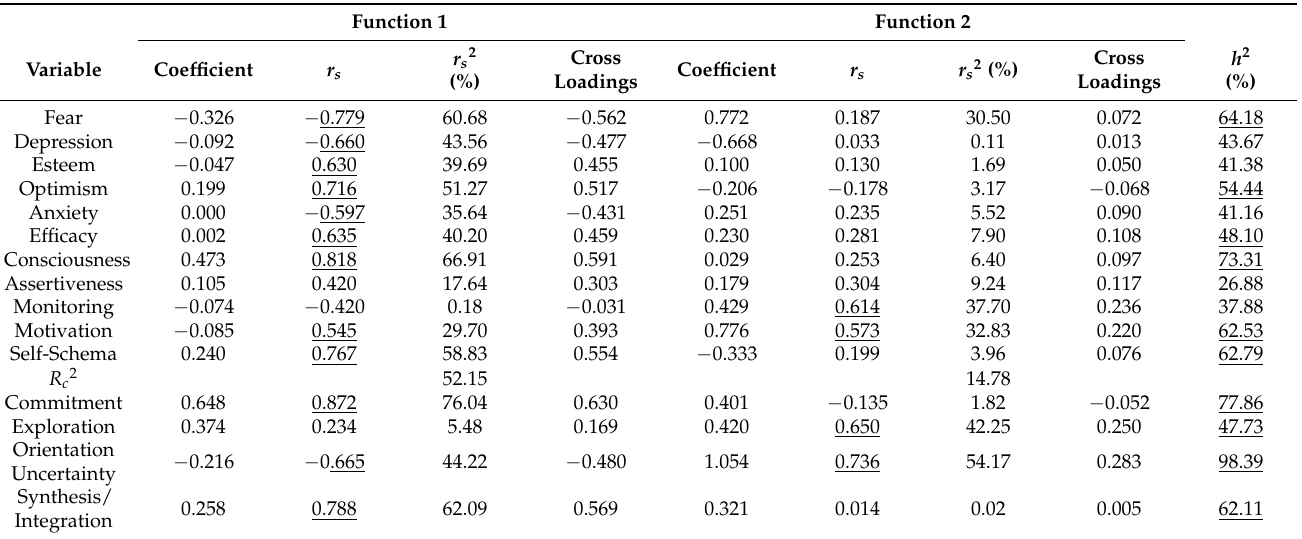
Table 2. Canonical solution for sexual identity development predicting sexual self-concept for functions 1 and 2 ( n =